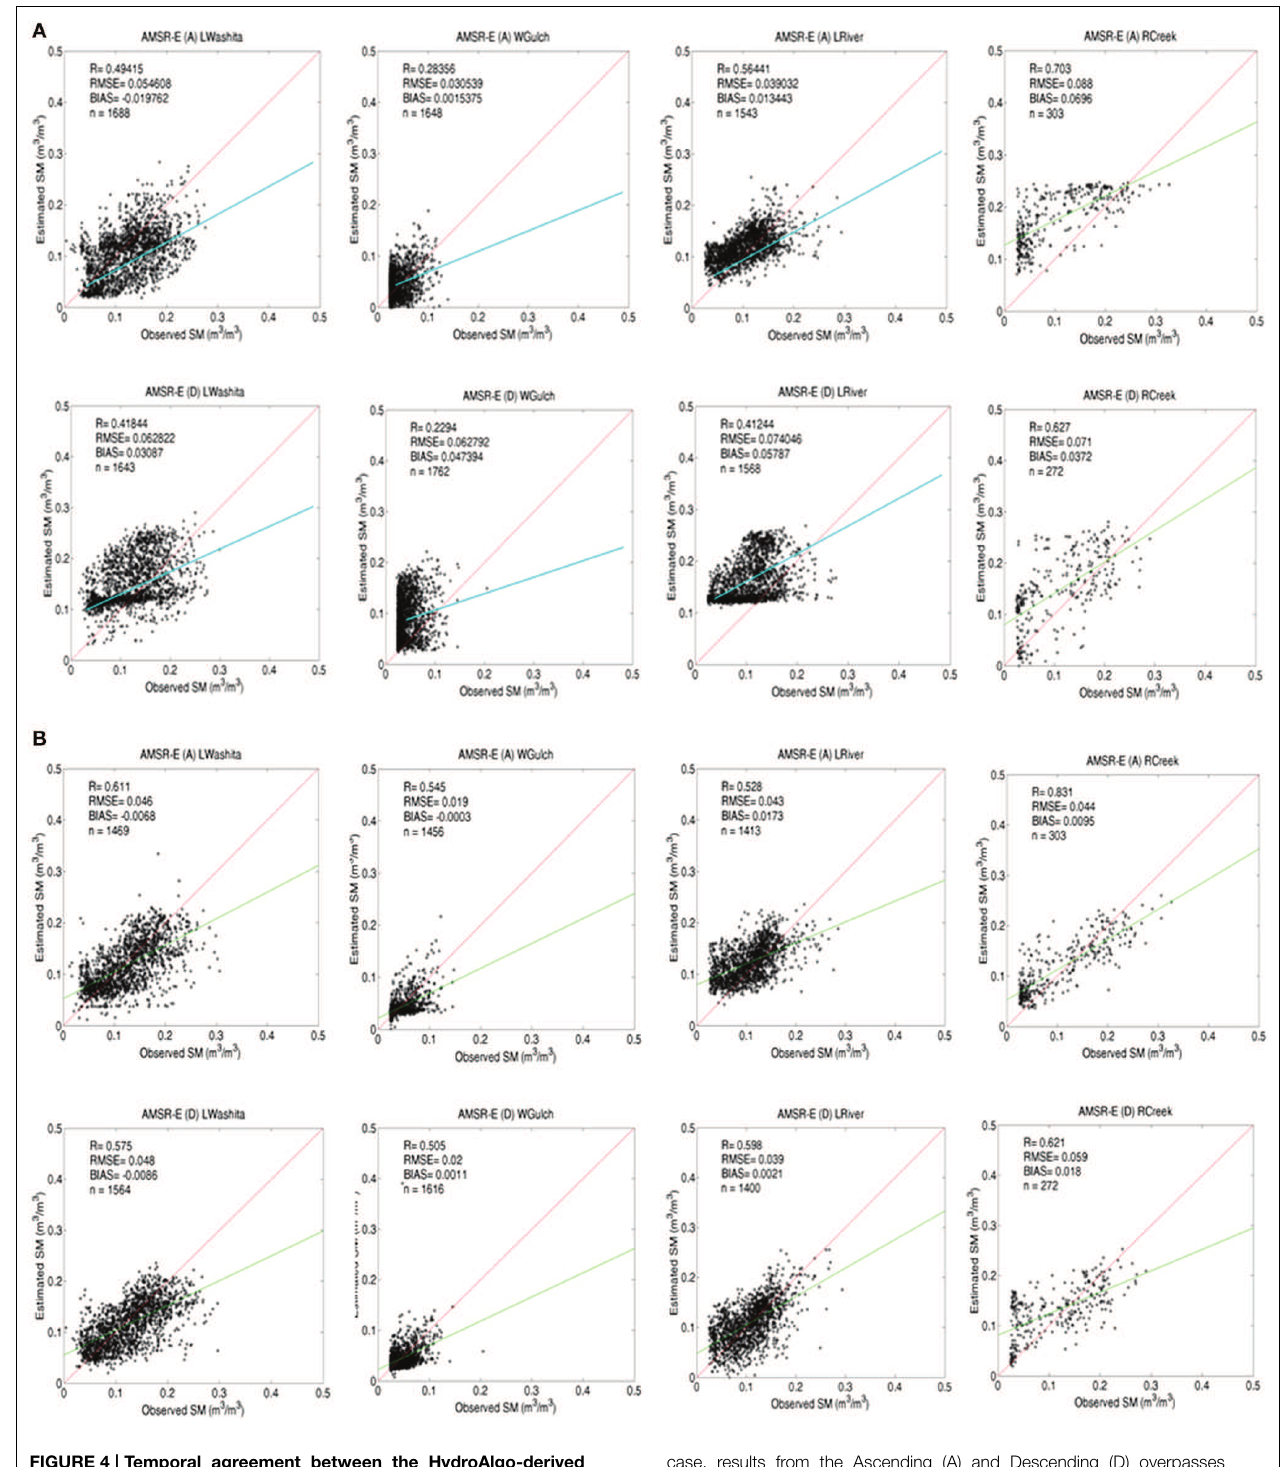
case, results from the Ascending (A) and Descending (D) overpasses were analyzed separately and are presented in the top and the bottom row, respectively. Continuous lines represent the regression equations and 1:1 lines